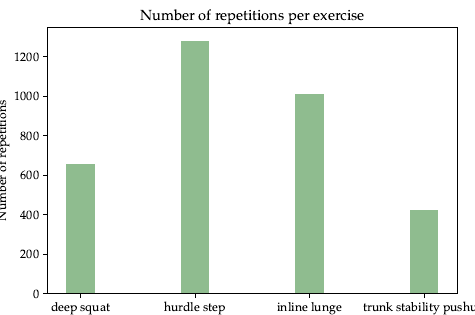
Figure 7. Number ob repetitions per FMS exercise in the presented dataset.